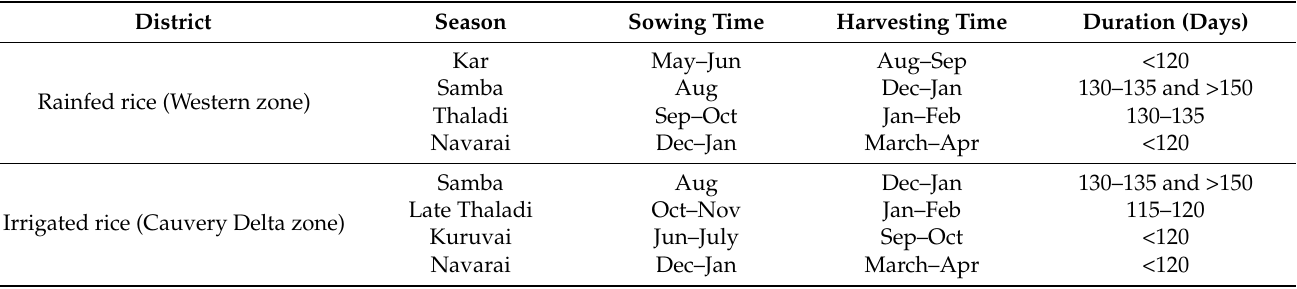
Figure 1. Location map of the study regions: Sadivayal, Coimbatore (western zone), and Karaikal (Cauvery Delta zone) in the Tamil Nadu state of India. Table 1. Sowing and harvesting time of major rice-growing seasons in Tamil